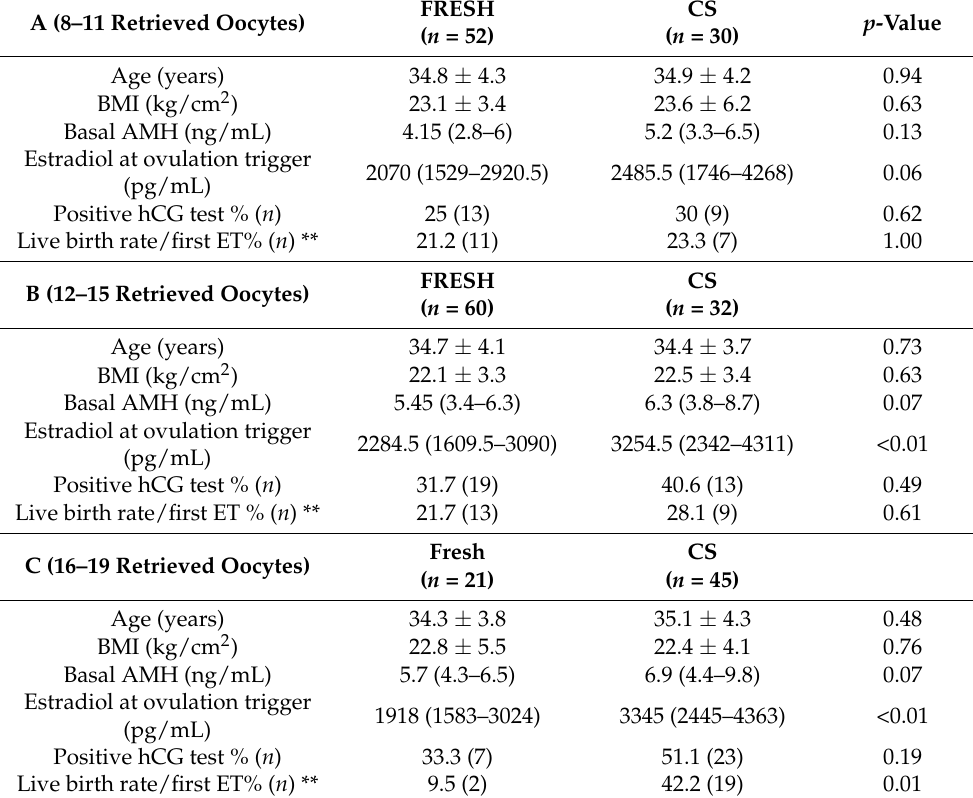
Table 3. Clinical baseline characteristics and IVF outcome of the patients receiving fresh ET plus hCG luteal supplementation (FRESH group) vs. those undergoing cycle segmentation with freezing of all embryos and delayed ET (CS group). Women were stratified according to the number of retrieved oocytes in order to normalize for the ovarian response to COS: A = 8–11 retrieved oocytes; B = 12–15 retrieved oocytes; C = 16–19 retrieved oocytes. Data are expressed as mean ± standard deviation or median (IQR), as appropriate, if not otherwise stated. ** In both groups, only the first ET was